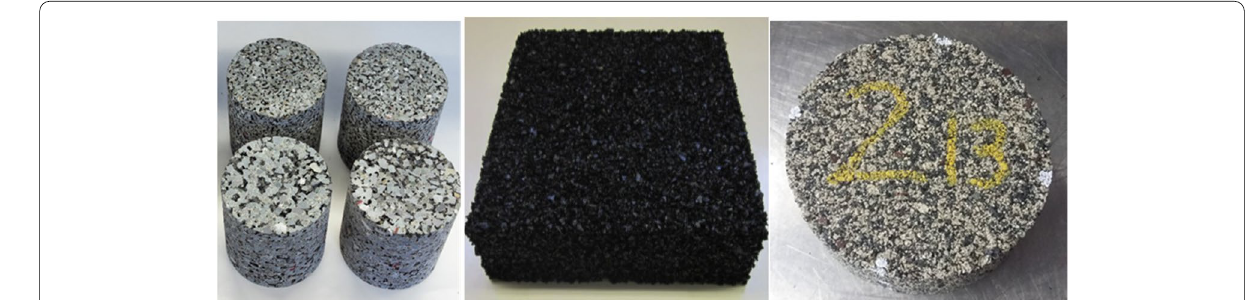
Fig. 4 Samples of PUPM